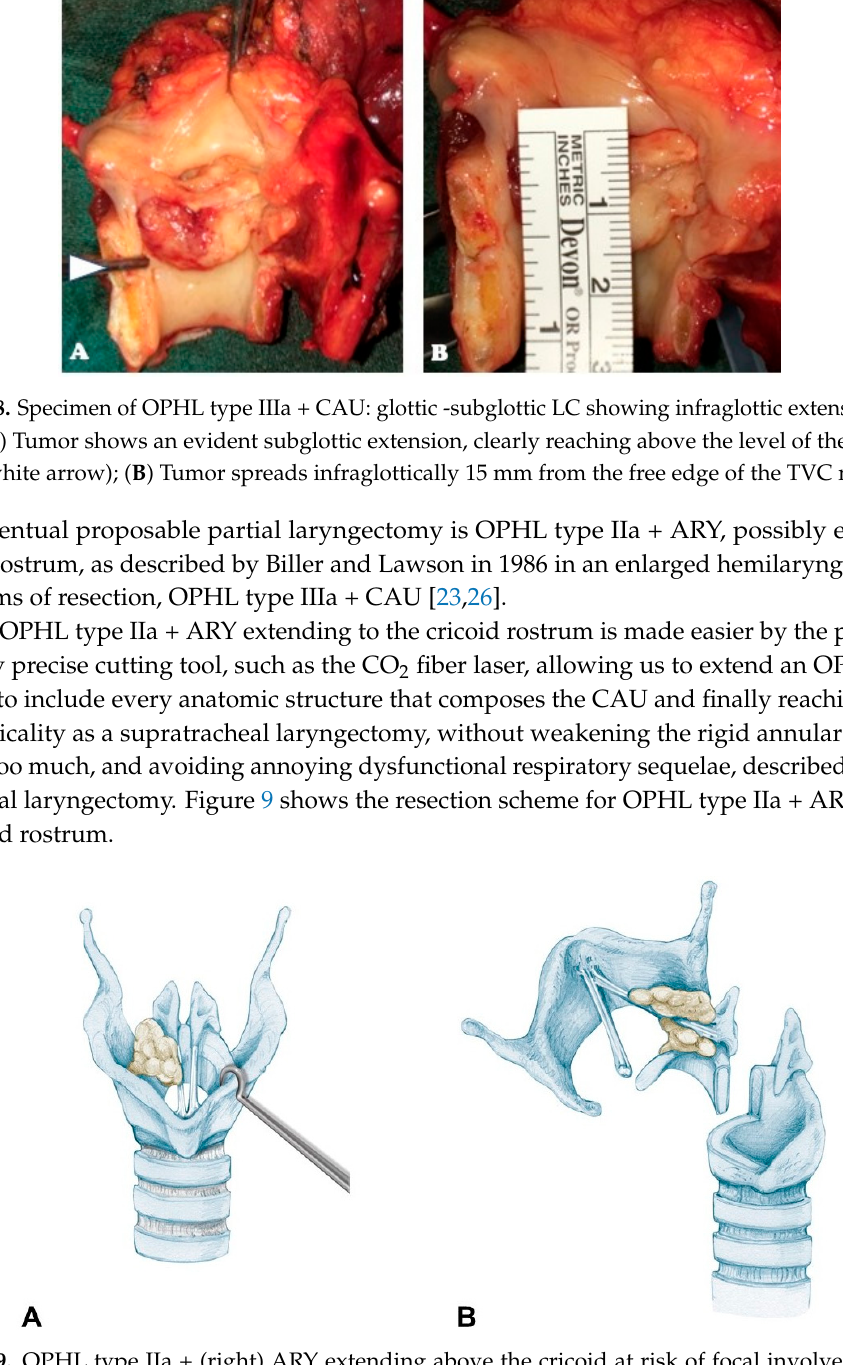
Figure 9. OPHL type IIa + (right) ARY extending above the cricoid at risk of focal involvement of the cricoid plate: ( A ) Before the resection: glottic carcinoma invading the posterior paraglottic space and extending down to the CAU; ( B ) The OPHL IIa + right ARY resection is extended to a part of the cricoid plate corresponding to the superficial extension of the tumor.